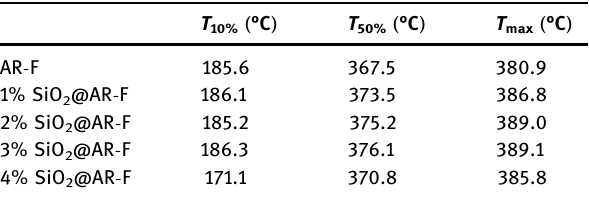
Table 1: Thermal stability of di ff erent silica content fi lms